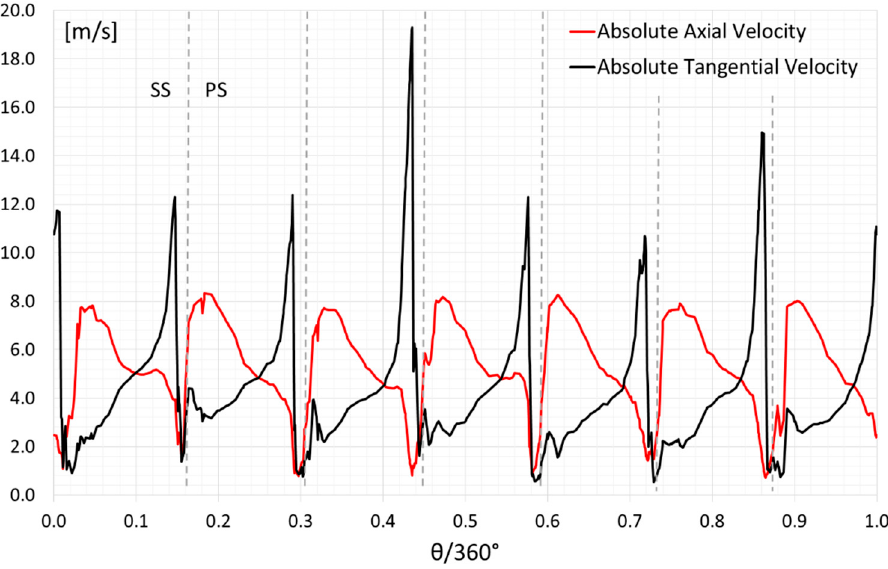
Figure 19. Representation of the axial and tangential components of the absolute velocity vector along the mean radius at the trailing edge of the blade (BEP operating point).